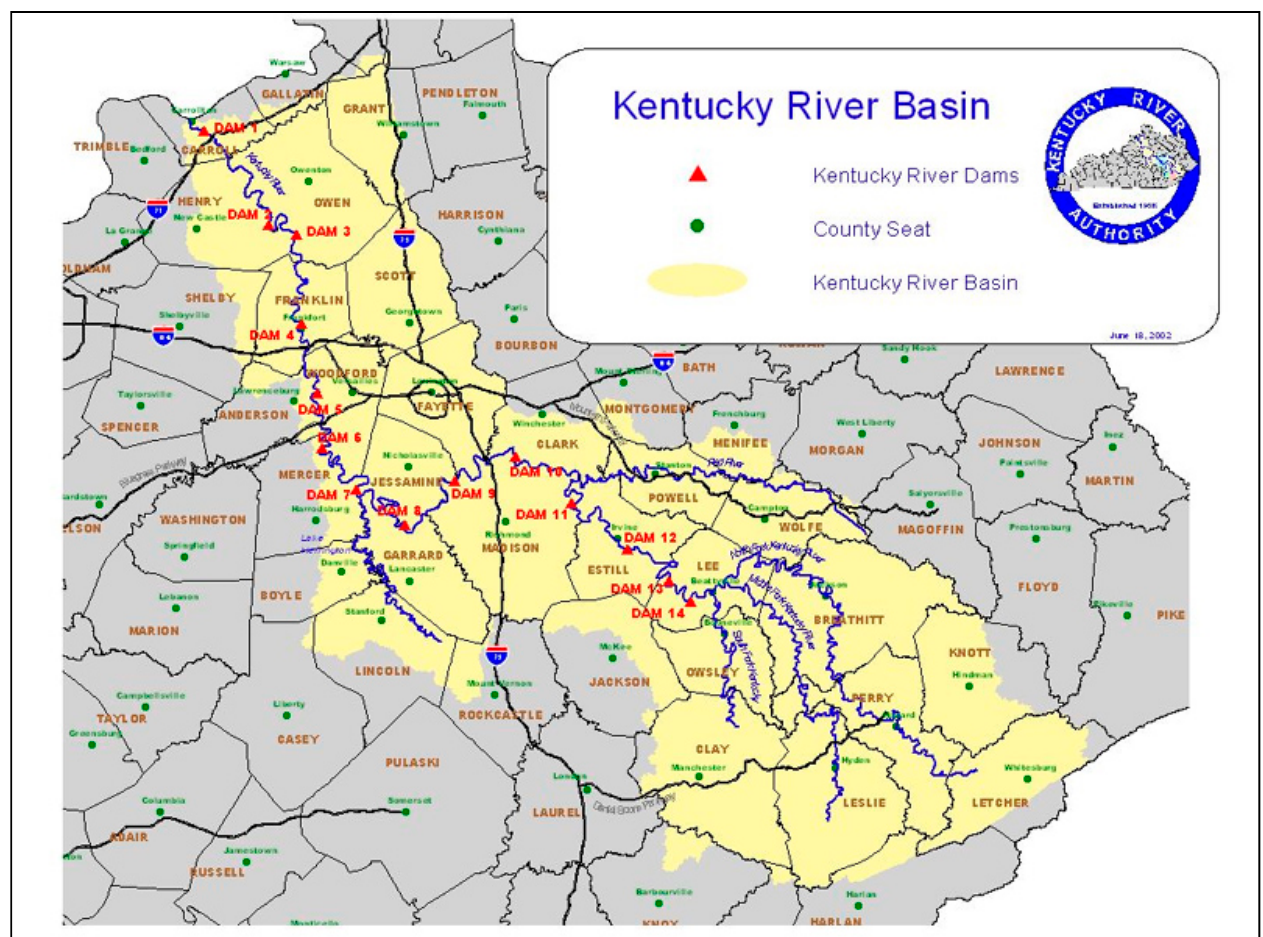
Figure 1. The Kentucky River Basin with its 14 locks and dams [21].